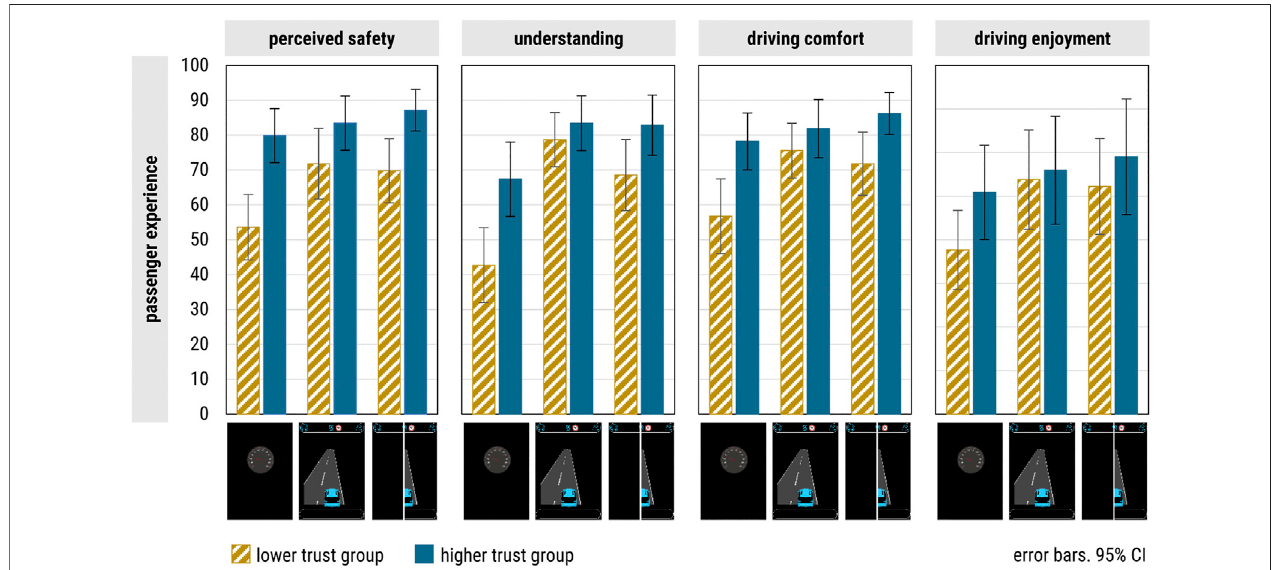
FIGURE 4 | Trust group-speci fi c passenger experience reported after automated driving with no (left) , permanent (middle) and context-adaptive (right) HMI.